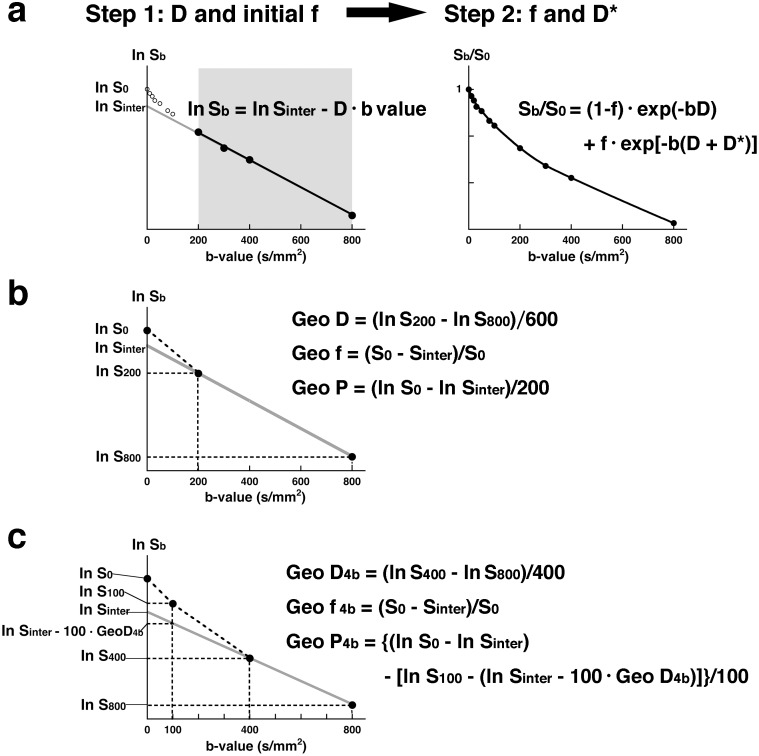
IVIM parameter determination by least-squares or geometric method.
a, Least-squares method. Upper panel shows a representative signal decay curve obtained by using 11 b-values (0, 10, 20, 30, 50, 80, 100, 200, 300, 400, 800 s/mm2). At first step, D (Fit D) can be obtained by least-squares method using ln S200, ln S300, ln S400, and ln S800, and initial f value is calculated as , where Sinter is the interception of the logarithmic regression line obtained by using b-values of 200, 300, 400, and 800 s/mm2 with the y-axis. Right panel shows relationship between Sb/S0 and varying b-values. Given D and initial f and D* values, f (Fit f) and D* (Fit D*) values can be obtained by least-squares method based on the equation: . b, Geometric method. Graph shows geometric determination of IVIM parameters using 3 (0, 200, and 800 s/mm2) of the 11 b-values. D is calculated by the equation . f is estimated by the equation , and P is estimated by the equation Geo P = (ln S0–In Sinter)/200. c, Geometric method based on 4-b-value data. Graph shows geometric determination of IVIM parameters using 4 (0, 100, 400, and 800 s/mm2) of the 11 b-values. D is calculated by the equation , f is estimated by the equation , and P is estimated by the equation .